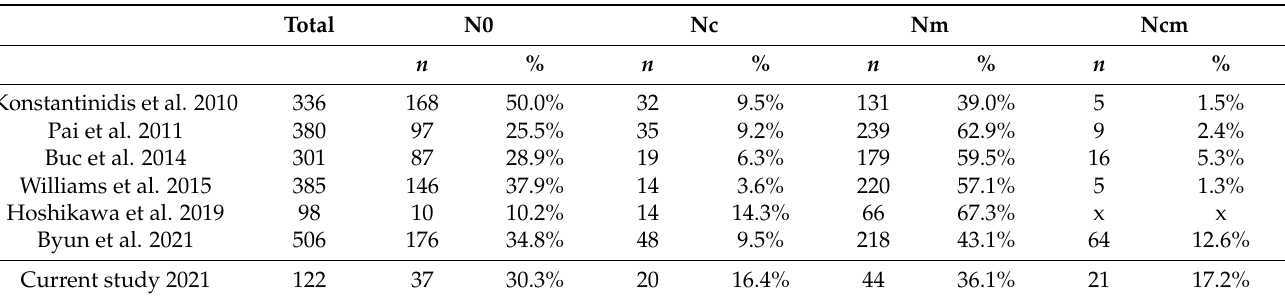
Table 3. Proportions of lymph node types of the latest